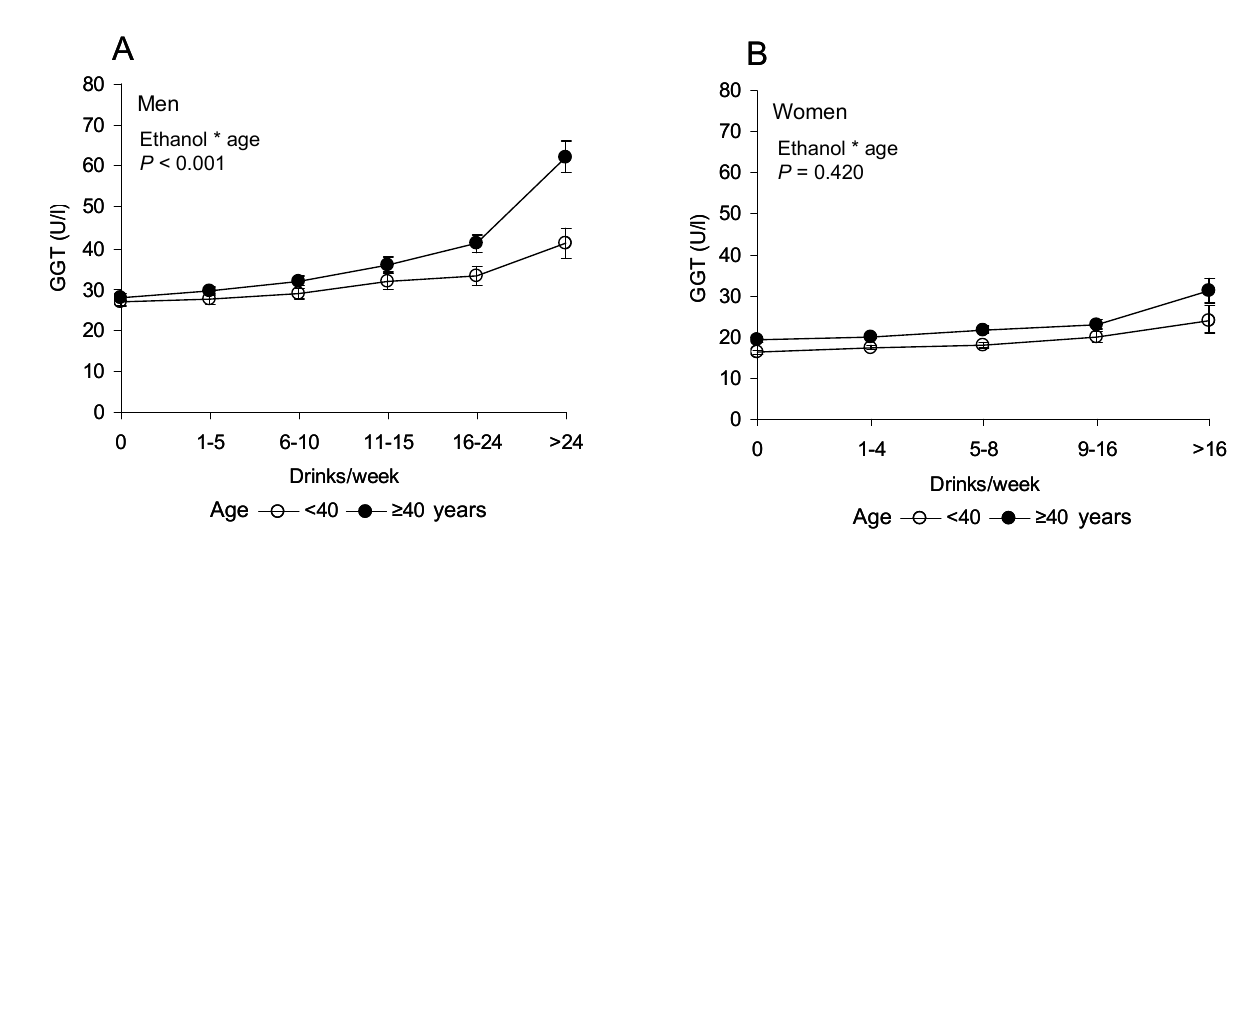
Figure 1. Gamma-glutamyltransferase (GGT) levels (mean ± 95% confidence interval (CI)) in men ( A ) and women ( B ) in subgroups divided according to the amount of ethanol intake and age. ( A ) In men, there was a significant two-factor interaction between ethanol use and age ( p < 0.001). In men over 40 years of age, GGT levels increased sharply after ethanol consumption exceeded 16 drinks per week. ( B ) In women, the interaction between ethanol and age was not significant. BMI (kg/m 2 ) and smoking (cigarettes/day) were used as